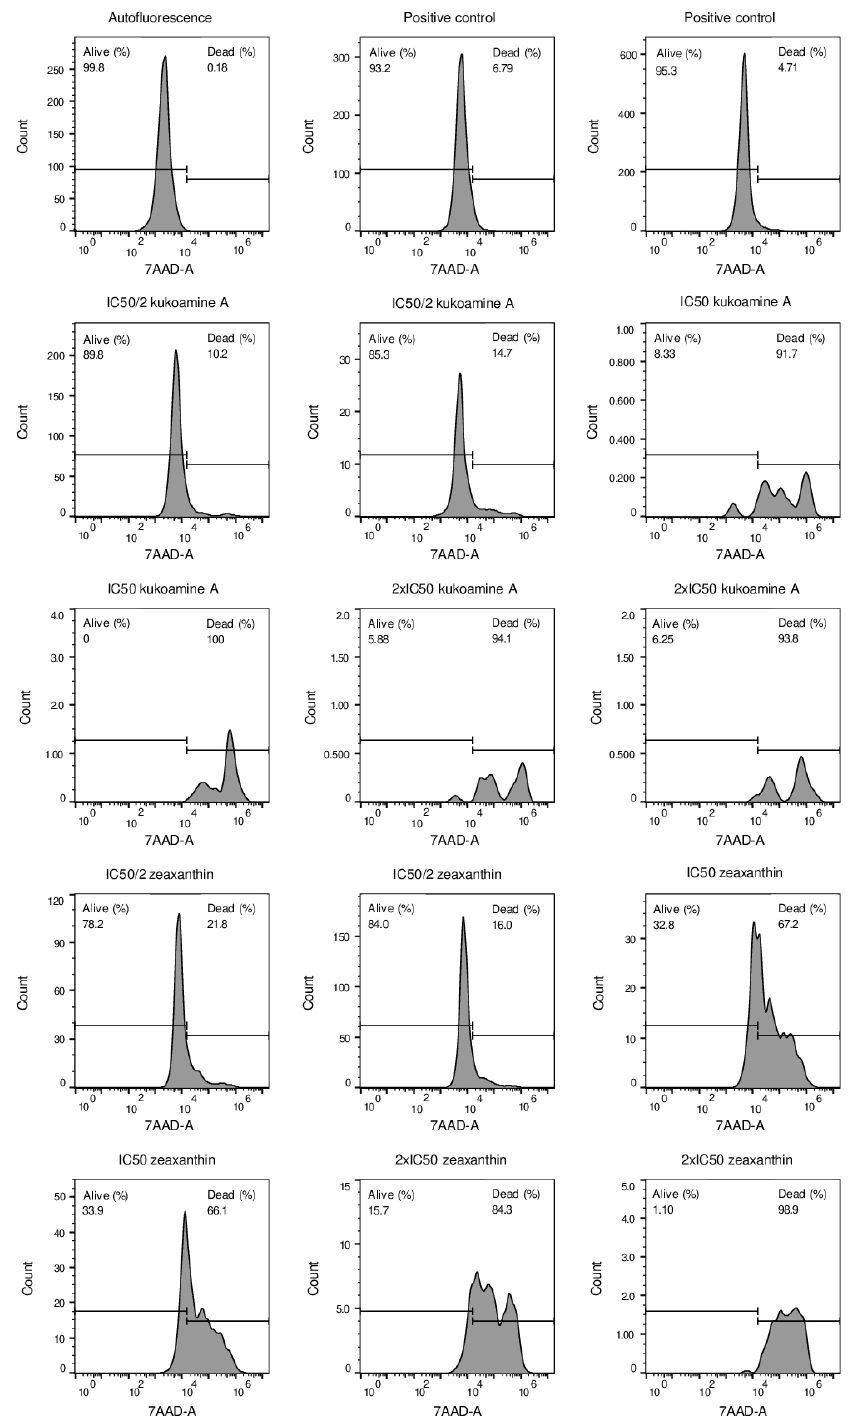
Figure 3. Viability percentage of 293T HEK cells at different Kukoamine A or Zeaxanthin concentrations. Y-axis represents cell count by cytometer, whereas X-axis shows 7-AAD fluorescence intensity. Autofluorescence sample delimits 7-AAD positive and negative cell regions. Positive control represents cells without bioactive compounds. Each sample type was duplicated.